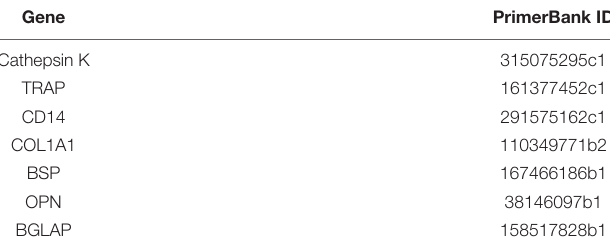
TABLE 1 | PrimerBank IDs of primer sequences used for